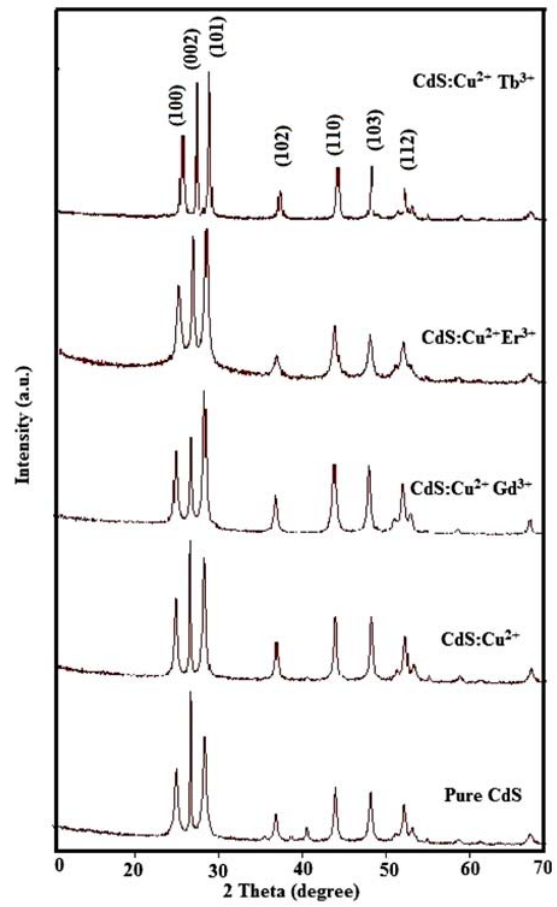
Figure 1. PXRD patterns for (a) undoped CdS (b) CdS:Cu 2+ (c) CdS:Cu 2+ Gd 3+ (d) CdS:Cu 2+ Er 3+ (e) CdS:Cu 2+ Tb